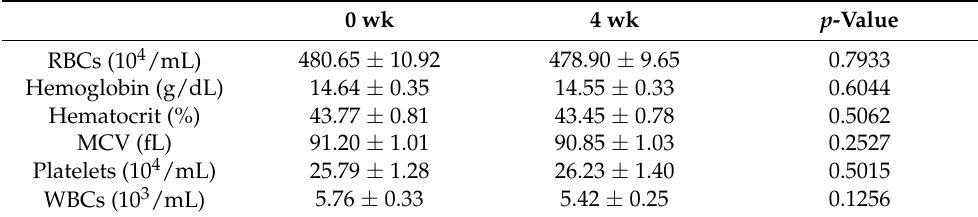
Table 3. Hematology values of subjects enrolled in this